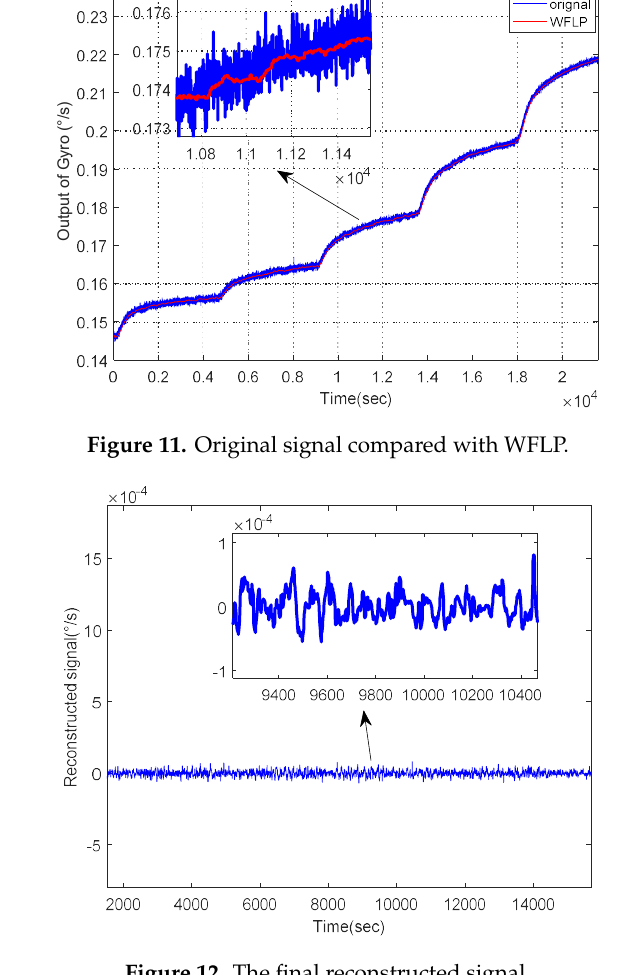
Figure 12. The final reconstructed signal.